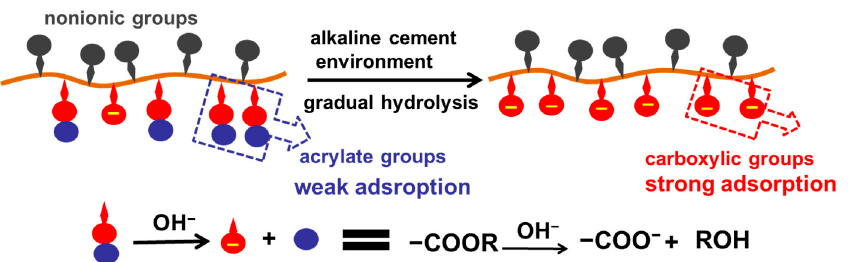
Figure 16. Schematic illustration of the gradual hydrolysis of acrylate-based post-acting polymers in an alkaline cement environment. Authorized reprint from [209].